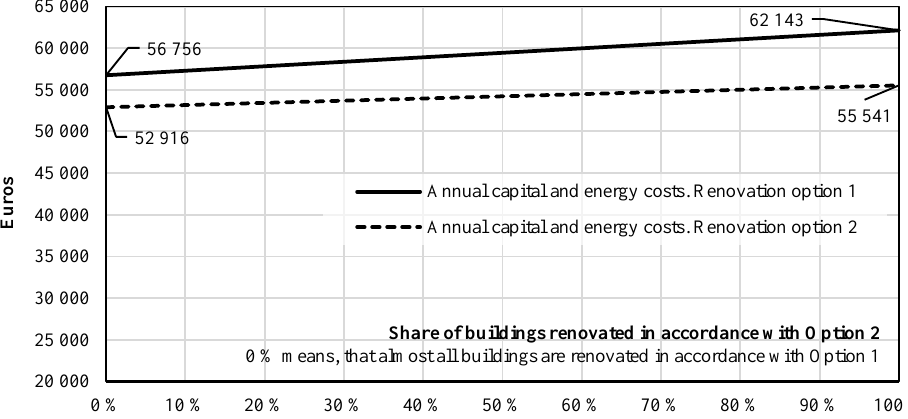
Fig. 5. Impact of an increased share of Option 2 building renovation solution implementation on annual capital and energy costs for buildings renovated in accordance with Option 1 and Option